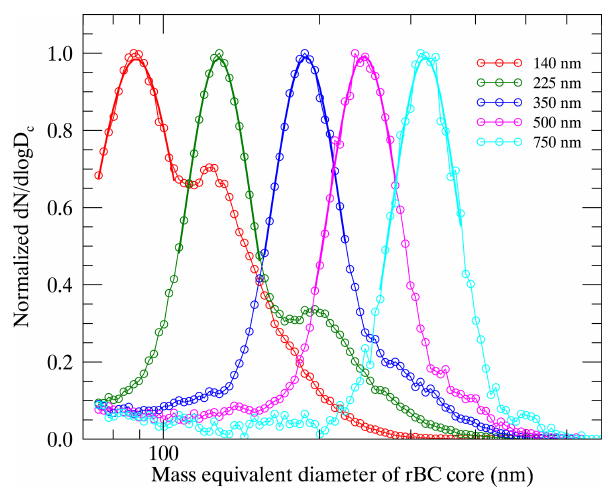
Figure 2. Campaign average number size distribution of the mass- equivalent diameter of the rBC core of extBC normalized by the peak value at five representative mobility diameters (140, 225, 350, 500 and 750nm) selected by the DMA. Lognormal fitting is per- formed for the major peak of each